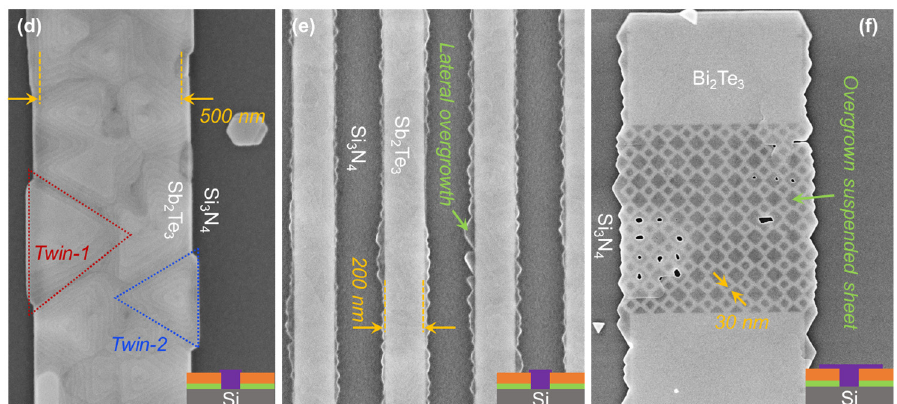
Figure 3. Pattern dimensions vs. effective growth rate ( R eff ). SEM images of SAE of BST alloy in nano-trenches with ( a ) W = 500 nm and ( b ) W = 200 nm exhibits overgrowth, with lateral extension of the layer on the blocking surface, and ( c ) W = 30 nm exhibits excessive lateral overgrowth and deformations at the edges confirming R eff >> R TF . The effects of enhanced R eff are also witnessed during SAE of Sb 2 Te 3 , where trenches with ( d ) W = 500 nm demonstrate high surface roughness and the formation of rotational domains. ( e ) For a reduced width of W = 200 nm, lateral overgrowth is observed. The effects of elevated R eff , when dimensions of both W and L go towards the nanoscale regime, can be observed in ( f ) where Bi 2 Te 3 overgrowth results in the formation of a suspended sheet of TI layer.